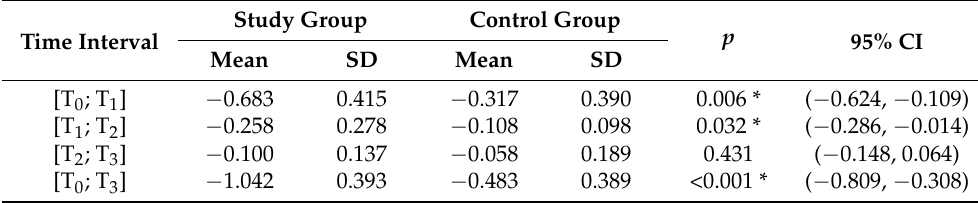
Table 4. Comparison of PPD changes. Mean and SD of average value of six measurements in each tooth.